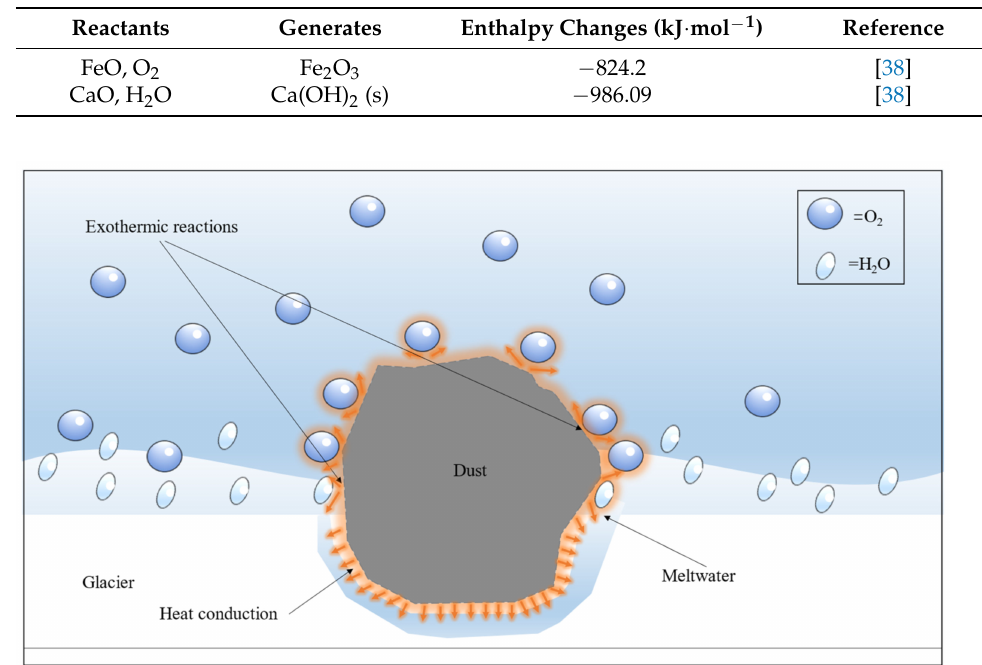
Figure 15. Energy conversion mechanism of mineral